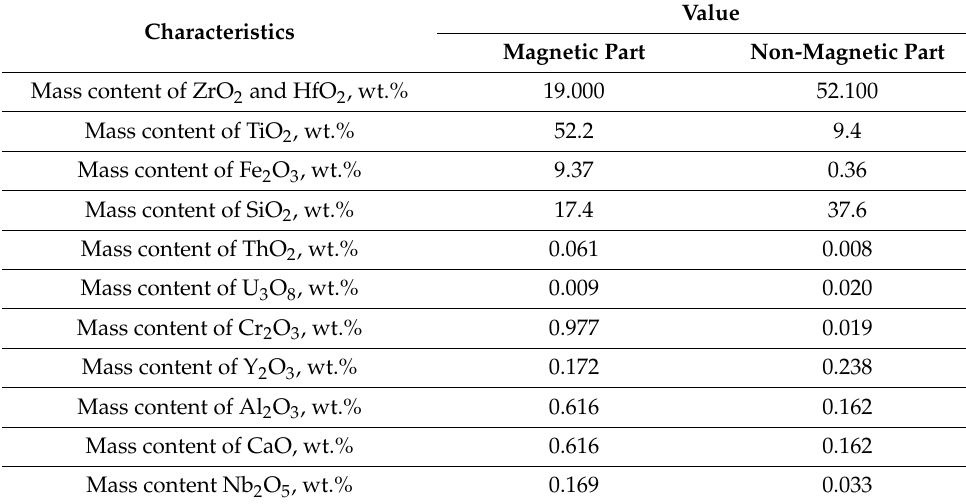
Value Magnetic Part Non-Magnetic Part